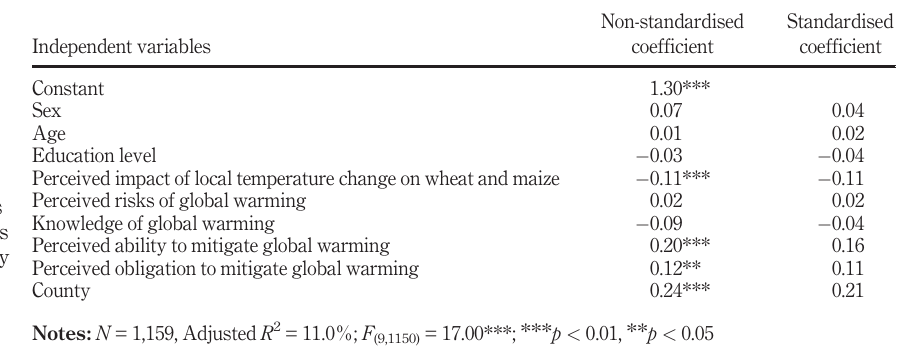
Non-standardised